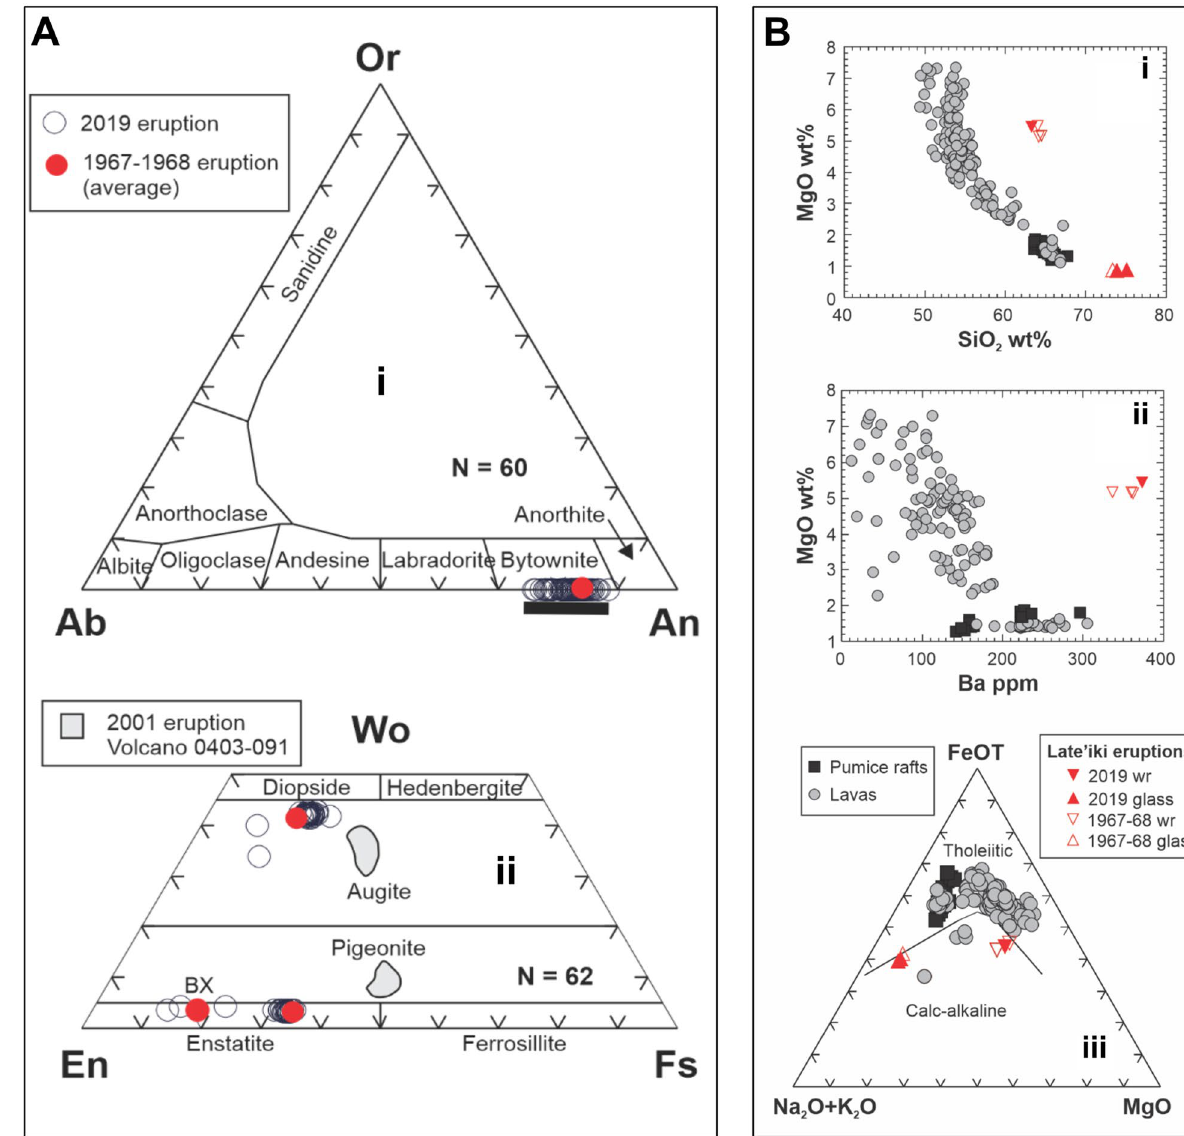
Figure 6. ( A ) Phenocryst compositions of the Late’iki lavas produced in the 1967–1968 and 2019 eruptions. Averaged compositions for the 1967–1968 lava are from Ewart et al. 2 . The data are further compared with phenocryst compositions from dacite pumice produced in the 2001 eruption of Volcano 0403-091, ~ 105 km to the north-northeast in the Tofua Arc 8 . ( i ) Feldspar phenocryst compositions. Range of plagioclase compositions from the 2001 eruption of Volcano 0403-091 indicated by black bar. Ab albite, An anorthite, Or orthoclase, N number of analyses. ( ii ) Pyroxene phenocryst compositions expressed in terms of the three-component system: wollastonite (Wo), enstatite (En), and ferrosillite (Fs), with field boundaries after Morimoto 61 . BX denotes the average composition of ‘bronzite’ xenocrysts identified by Ewart et al. 2 . Grey shade indicates the field of pyroxene compositions from the 2001 eruption of volcano 0403-091/Volcano F 8 . N is number of analyses. ( B ) Comparative geochemical plots of the Late’iki eruptions with erupted compositions from the Tofua arc (lavas are represented by grey filled circles, and pumice rafts-producing eruptions by blac-filled squares). ( I ) Harker plot of MgO vs SiO 2 content showing the highly magnesian character of the 1967–2019 Late’iki dacite lavas, having an equivalent MgO content to basaltic andesites In the Tofua Arc. ( Ii ) MgO vs Ba plot illustrating the Late’iki lavas have distinctive trace element compositions and have the highest Ba contents of all analysed volcanics from the Tofua Arc. ( Iii ) AFM diagram comparing the Tofua Arc lavas and dacitic pumice compositions from pumice raft forming eruptions that form a typical tholeiitic trend. In contrast the Late’iki lavas exhibit chemical features resembling calc-alkali series rocks. Data for Tofua Arc lavas from 2–4 . Pumice raft compositions from 7,8,13,62 . Compositions of the 1967–1968 Late’iki lava from 2,15,26